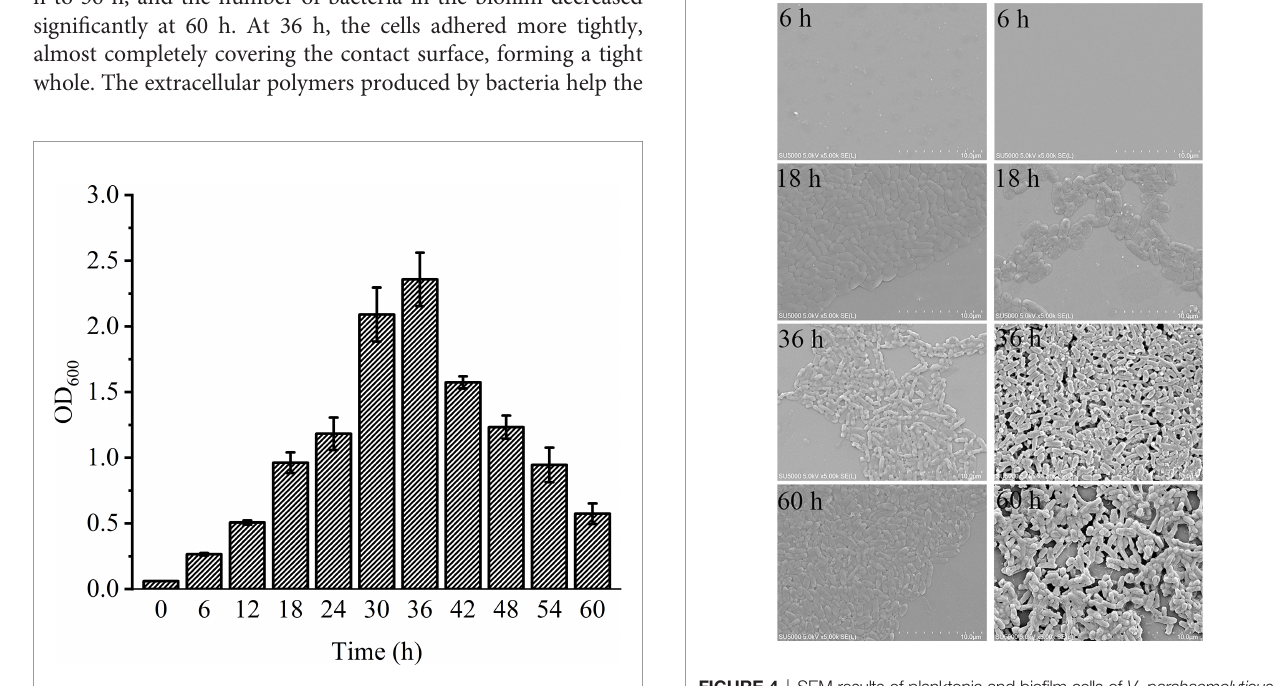
FIGURE 3 | Bio fi lm formation of V. parahaemolyticus .